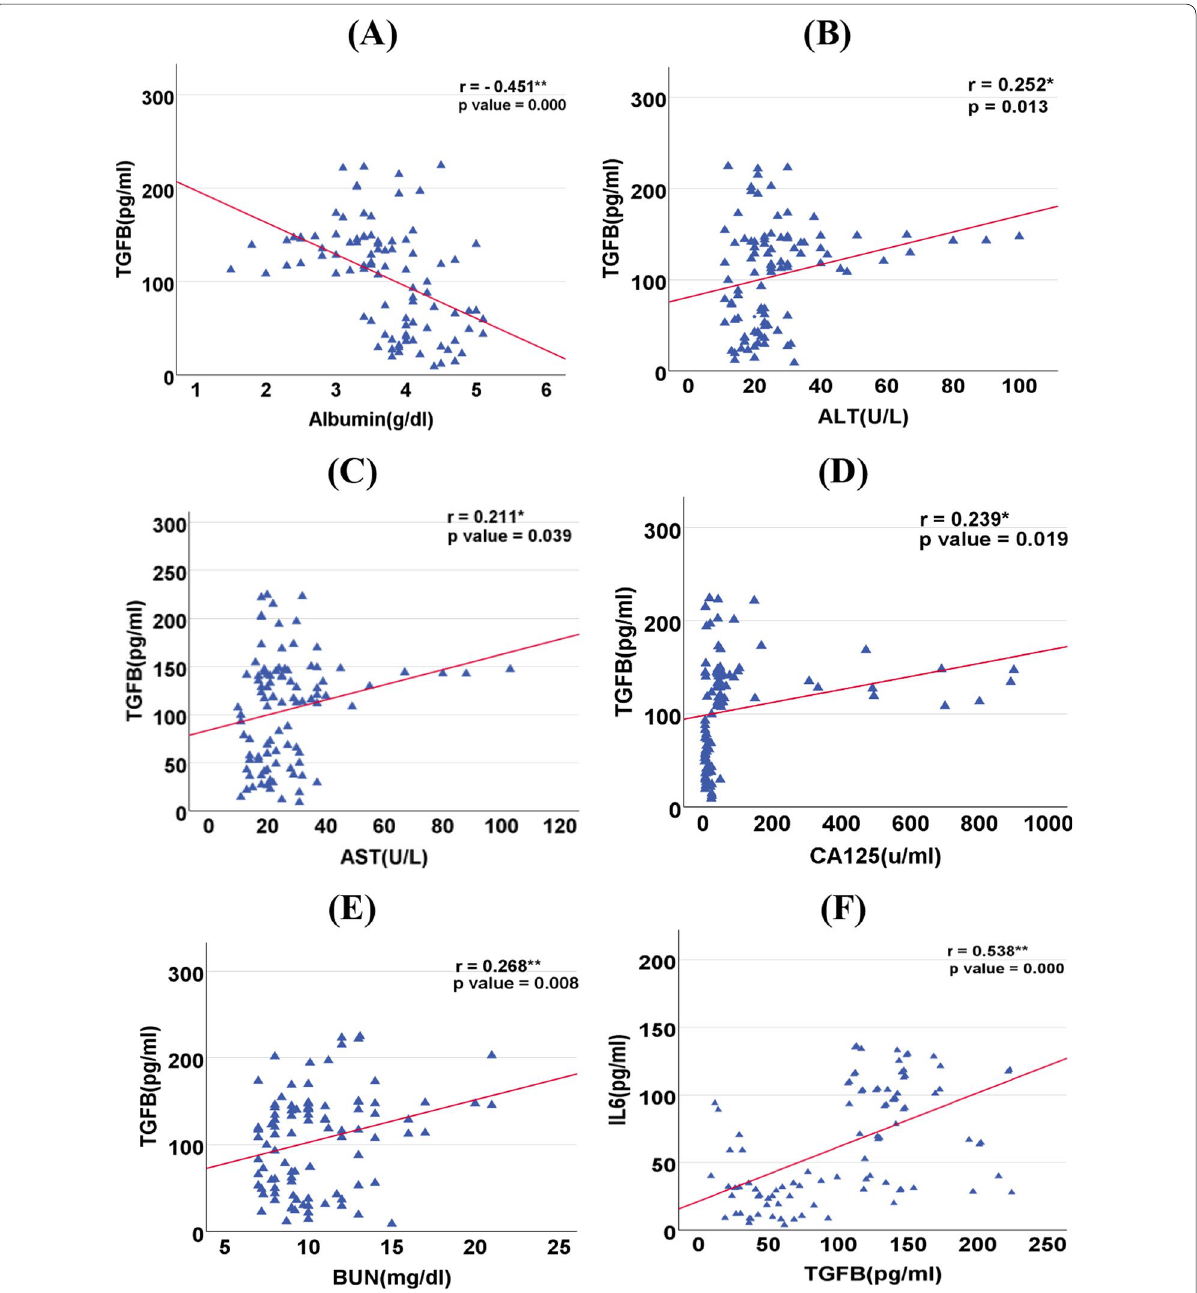
Fig. 6 Correlation between TGF‑β1 (pg/ml) with A Albumin, B ALT, C AST, D CA125, E BUN and F IL 6 levels among ovarian cancer and control groups.r, Pearson’s correlation coefficient. * P < 0.05; ** P < 0.01; *** P < 0.001. Abbreviations: IL interleukin, ALT Alanine aminotransferase, AST Aspartate aminotransferase; CA125 Cancer antigen 125, BUN blood urea nitrogen, TGFB transforming growth factor